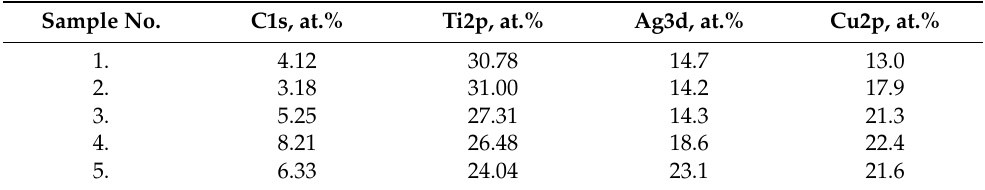
Table 1. Elemental composition of cosputtered TiO 2 /Ag/Cu nanocomposite coatings (from XPS) prepared under varied surface area of the Ag and Cu sheds.